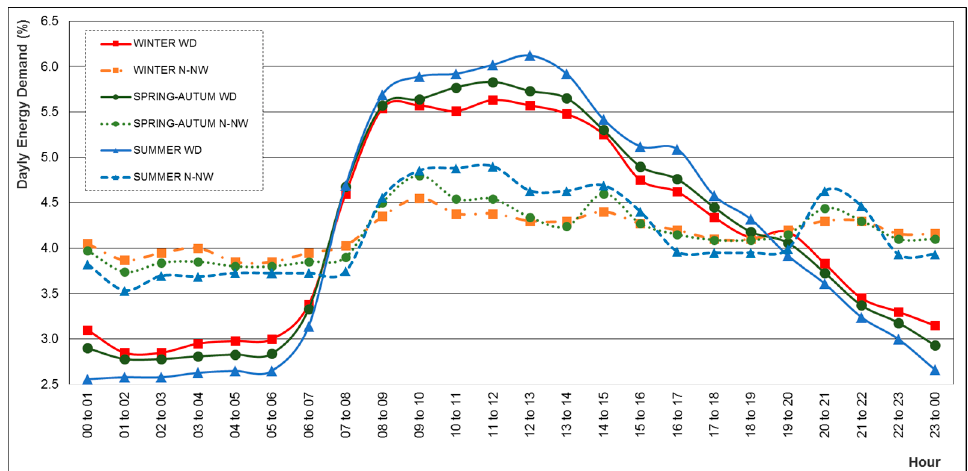
Figure 4. Percentage of daily demand in the Sec SS 3.